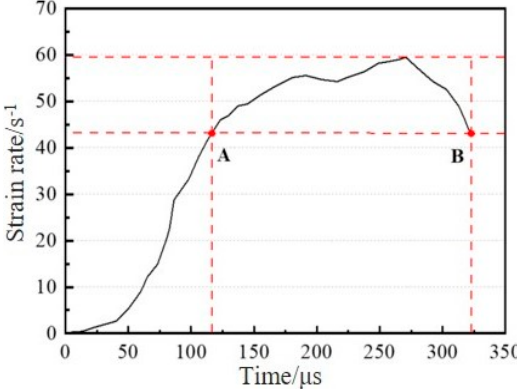
Figure 4. Schematic diagram of stress wave propagation.